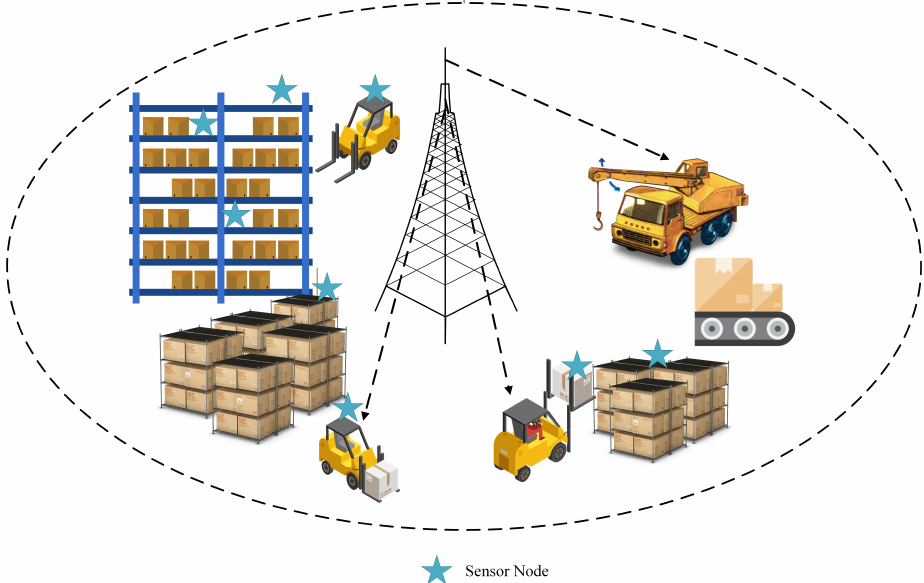
Figure 1. An intelligent power materials warehouse of a smart grid based on WSNs.